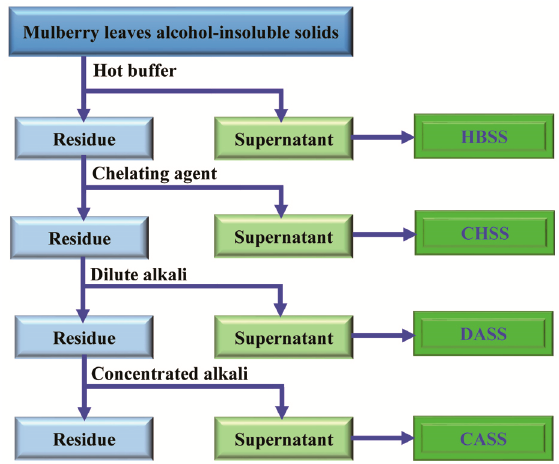
Figure 7. Flow diagram of the extraction procedure for different polysaccharide fractions.